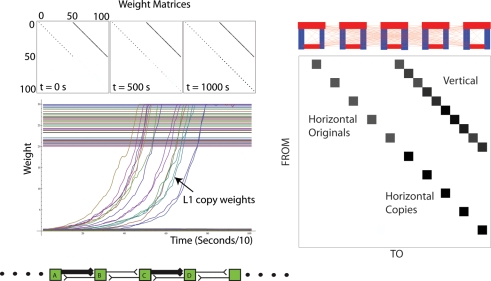
(Top Left)Weight matrices for two 50 neuron layers at the beginning, middle and end of the experiment. Weights in L0 are copied without error to L1. (Middle Left) Dynamics of weight change during the 1000 s experiment. Weights in L1 increase monotonically. (Bottom Left) A sample of the pattern present in L0. Strong weights pass from left to right, separated by weakly connected neurons. (Right) The weight matrix and corresponding view of the two layers at the end of an experiment with this time only 10 neurons in each layer. Again, copying is perfect, i.e. the red left-to-right connections (the neuronal equivalent of p-bonds) are copied perfectly from L0 to L1. Thick blue lines show fixed vertical connections from L0 to L1 (the neuronal equivalent of h-bonds).